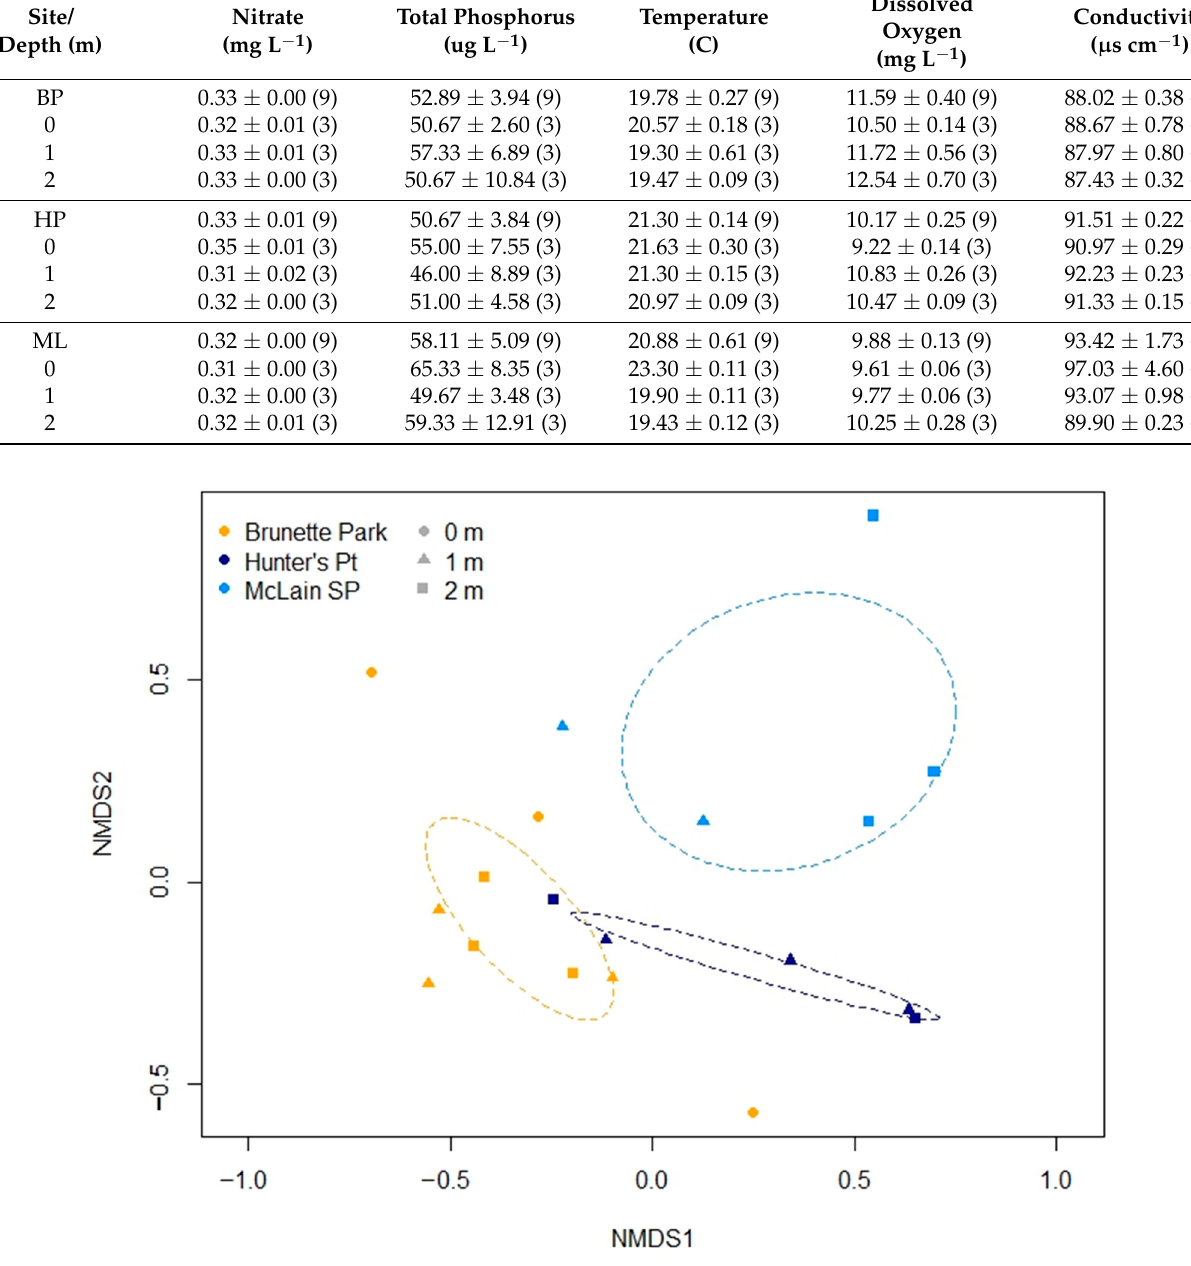
Figure 3. Ordination following non-metric multidimensional scaling of Bray-Curtis similarities of periphytic diatom communities determined at various depths (0–2 m) at Brunette Park ( n = 9), Hunter’s Point ( n = 5) and McLain State Park ( n = 5). Note that although nine samples were analyzed at each site, not all samples contained periphyton, especially in the active wave zone, z = 0 m. Stress = 12.84; ellipses per site represent the 95% confidence interval of the site centroid. Post-hoc Adonis revealed that periphyton communities were significantly different among sites ( p < 0.05).